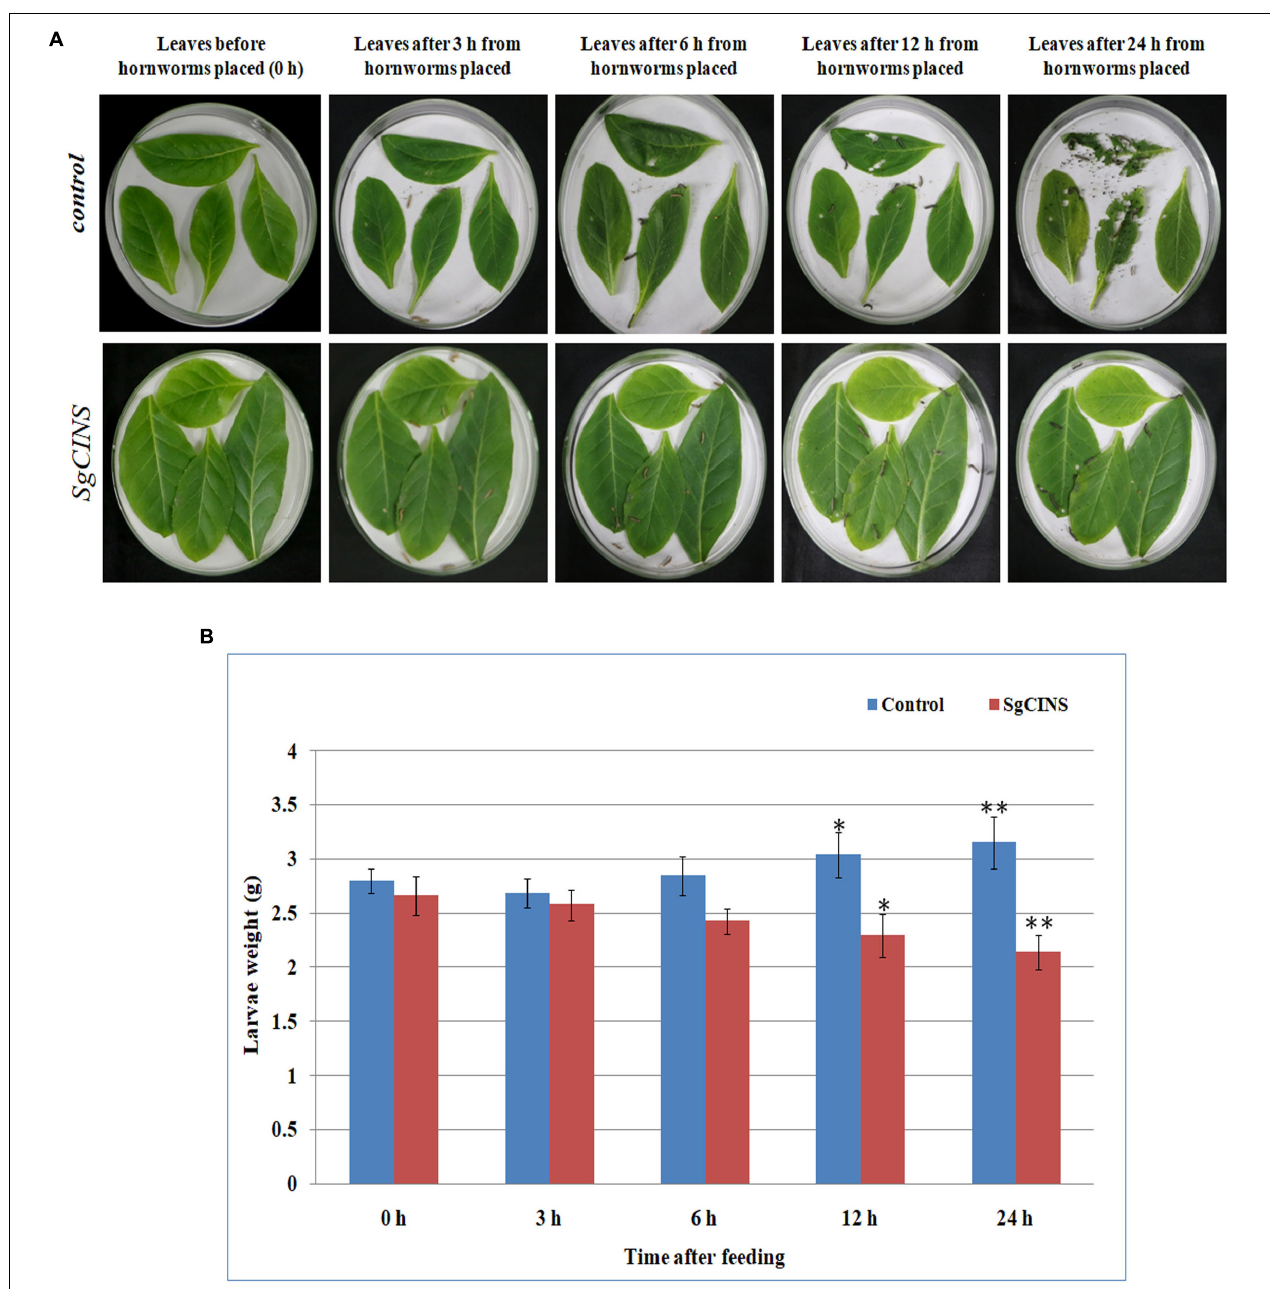
FIGURE 5 | Force-feeding assays for insect resistance on control and transgenic plants after at different times (i.e., 0, 3, 6, 12, and 24 h). (A) Insect force-feeding assays with third-instar larvae of cotton leafworms ( Prodenia litura ) on N. tabacum . (B) The relative growth rate (RGR) for cotton leaf worms after feeding on control and T1 transgenic tobacco plants at different times (i.e., 0, 3, 6, 12, and 24 h). Each bar represents the mean and SD of the weight and significances are based on the Student’s t -test ( ∗ p < 0.05; ∗∗ p <